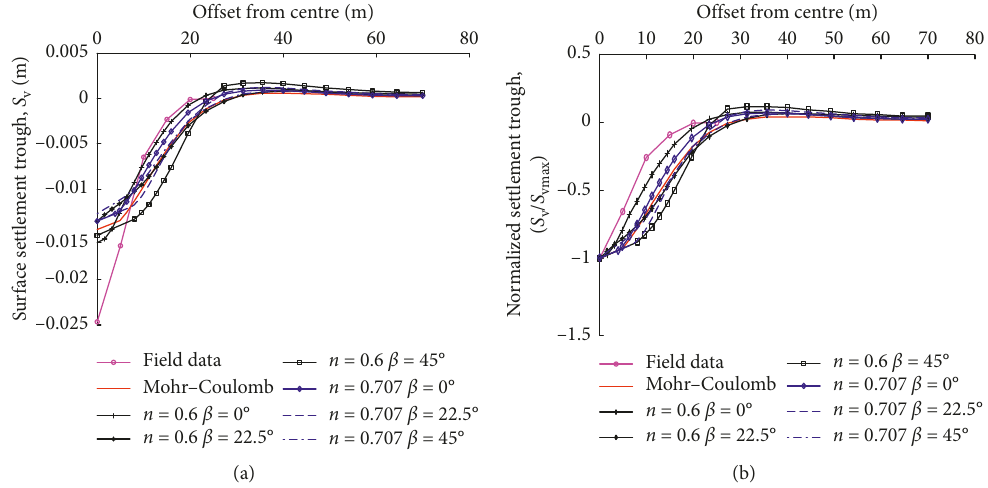
Figure 8: (a) Vertical displacement and (b) normalized settlement profiles with various values of n and β